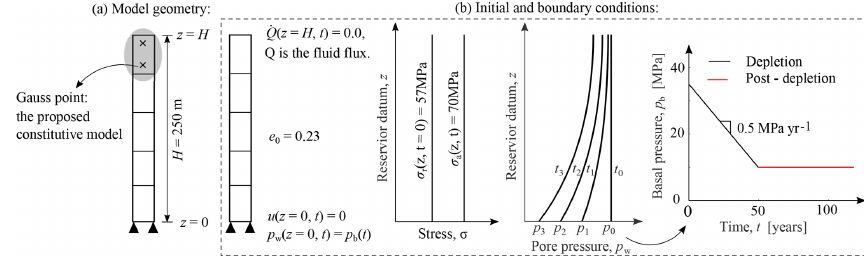
Figure 2. Schematic description of model setup: (a) model geometry; (b) initial and boundary conditions.